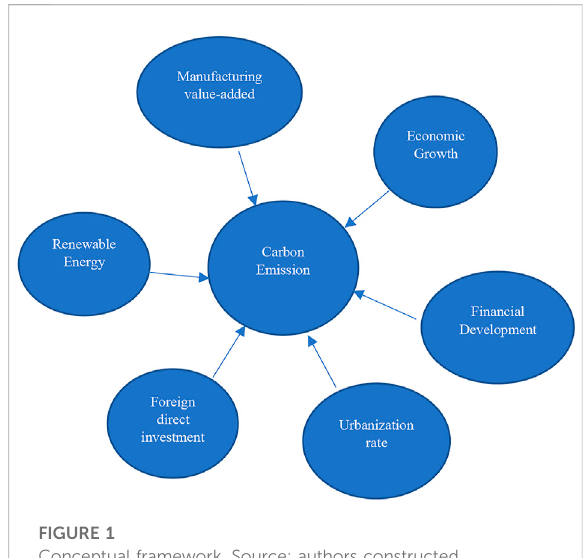
FIGURE 1 Conceptual framework. Source: authors constructed.